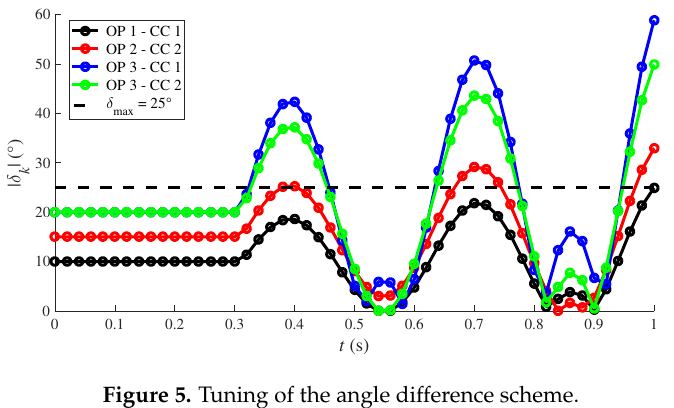
Figure 5. Tuning of the angle difference scheme. Table 2. Maximum angle difference allowed.